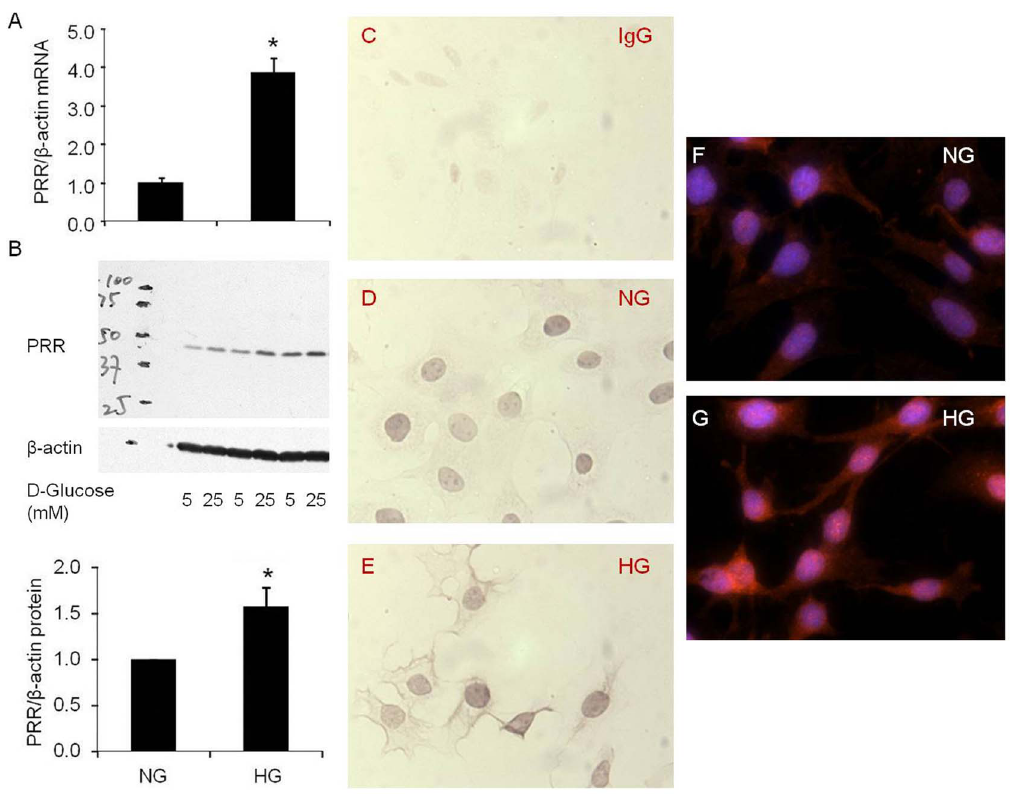
Figure 1. Effect of high glucose on PRR expression in podocytes. A. Real time PCR analysis of PRR mRNA expression in response to high glucose for 72 hours (n=6); B. Western blot analysis of PRR protein expression in response to high glucose for 72 hours (n=6); C, D and E. Immunohistochemistry staining of PRR shown in brown (n=3); F and G. Immunofluorescence staining of PRR shown in red, DAPI shown in blue (n=5).PRR, (Pro)renin receptor; normal glucose, 5 mM D-glucose (NG); high glucose, 25 mM D-glucose (HG). Data presented as mean 6 SEM, * p , 0.05 vs NG